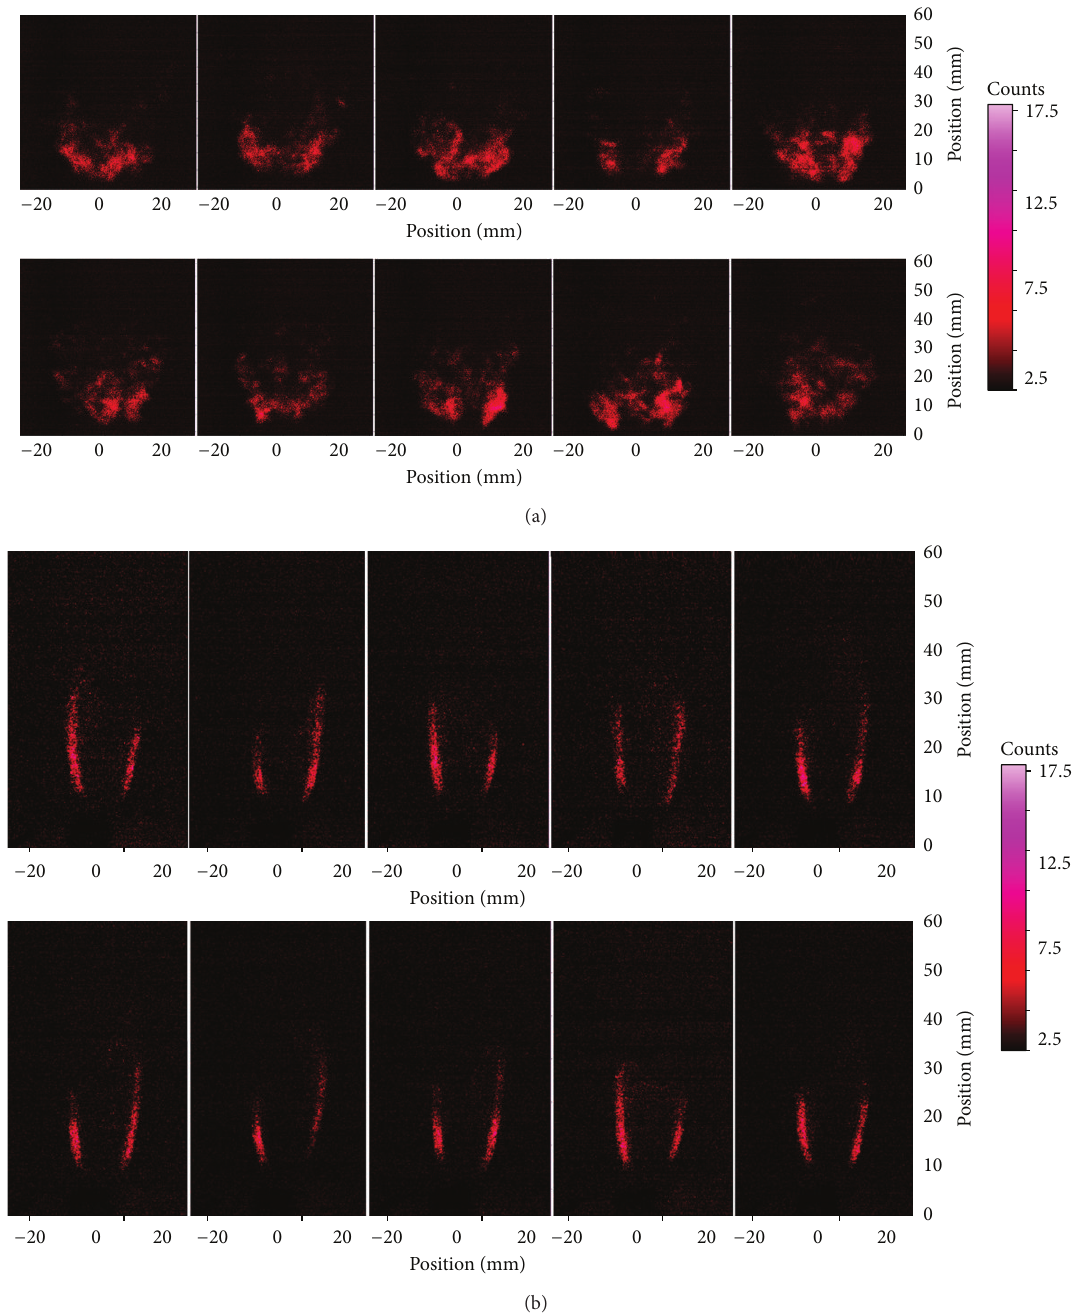
Figure 11: Instantaneous OH ∗ images for disk (a) and square (b) burner operating with a mixture level of 𝛿 = 6 % (disk) and 𝛿 = 14 % (square).